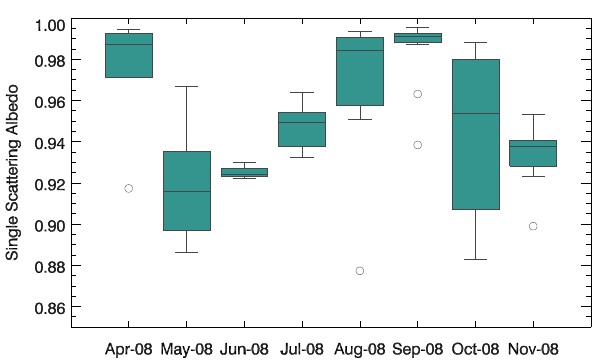
Fig. 9. Column average single scattering albedo estimated using skyradiometer data at 500nm over